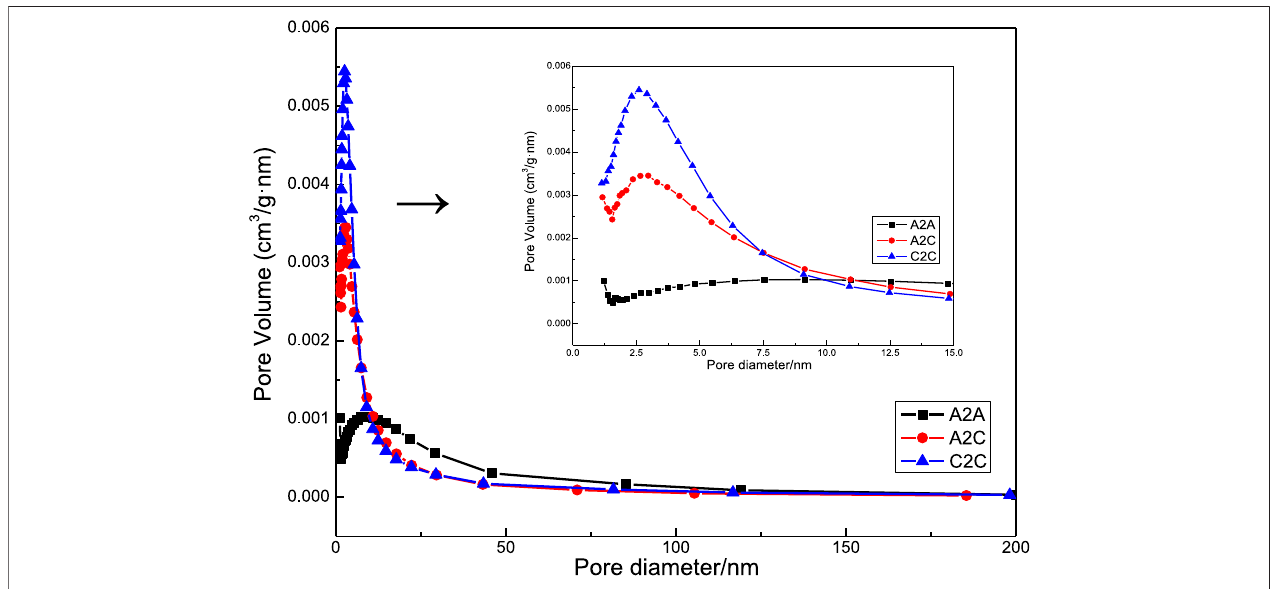
FIGURE 9 | Pore size distribution of the uncarbonated area sample in A2A-28d and carbonated area samples in A2C-1d and C2C-1d.